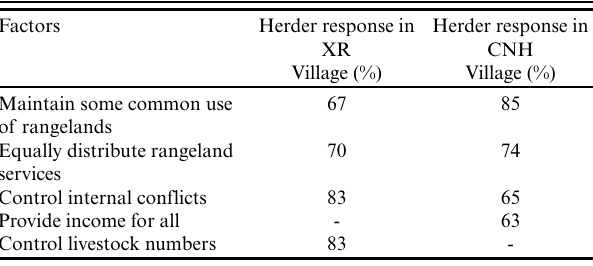
Table 1 . Herder responses to questions about their reasons for developing a community-based grazing quota